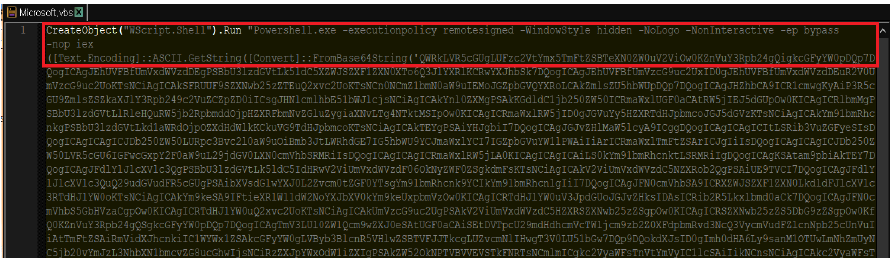
Figure 4. PowerShell command and Base64 encoding screen of the malicious file (Microsoft.vbs).